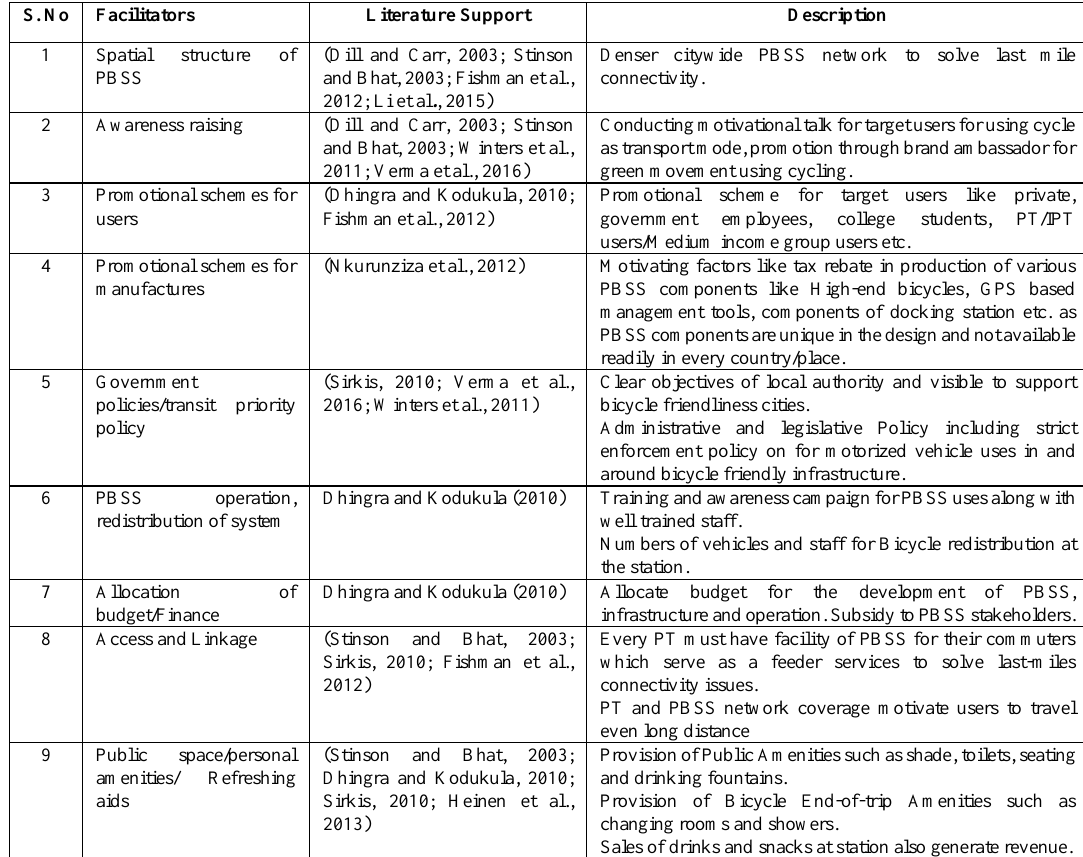
Table 1. List of facilitators for